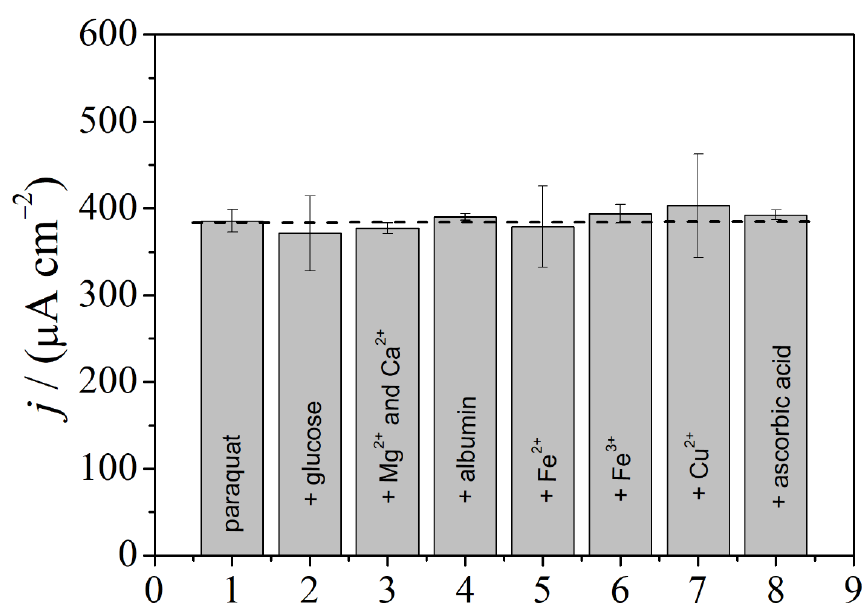
Figure 6. Effect of possible interferents on the SWV determination of a 50.0 µ mol L − 1 paraquat solution at 1/10 concentration ratios (analyte/interferent) in 0.1 mol L − 1 Na 2 SO 4 solution using the paper-based silver sensor.